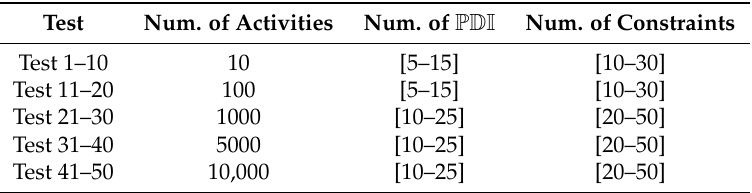
Table 3. Summary of the test cases used for evaluation.